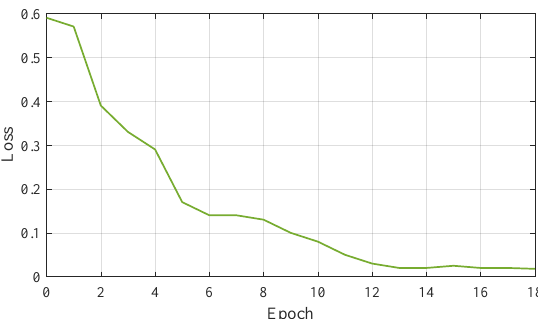
Figure 9. Loss curve for grid-connected radial mode operation.